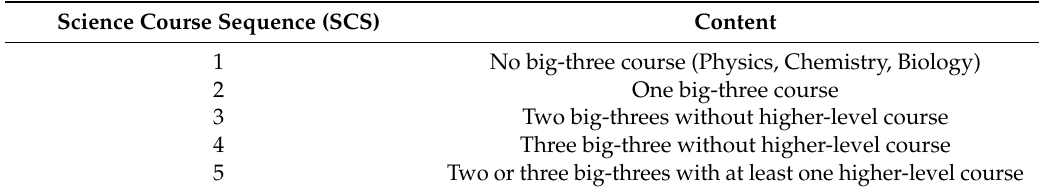
Table 2. Cumulative Science Course Sequence (SCS)